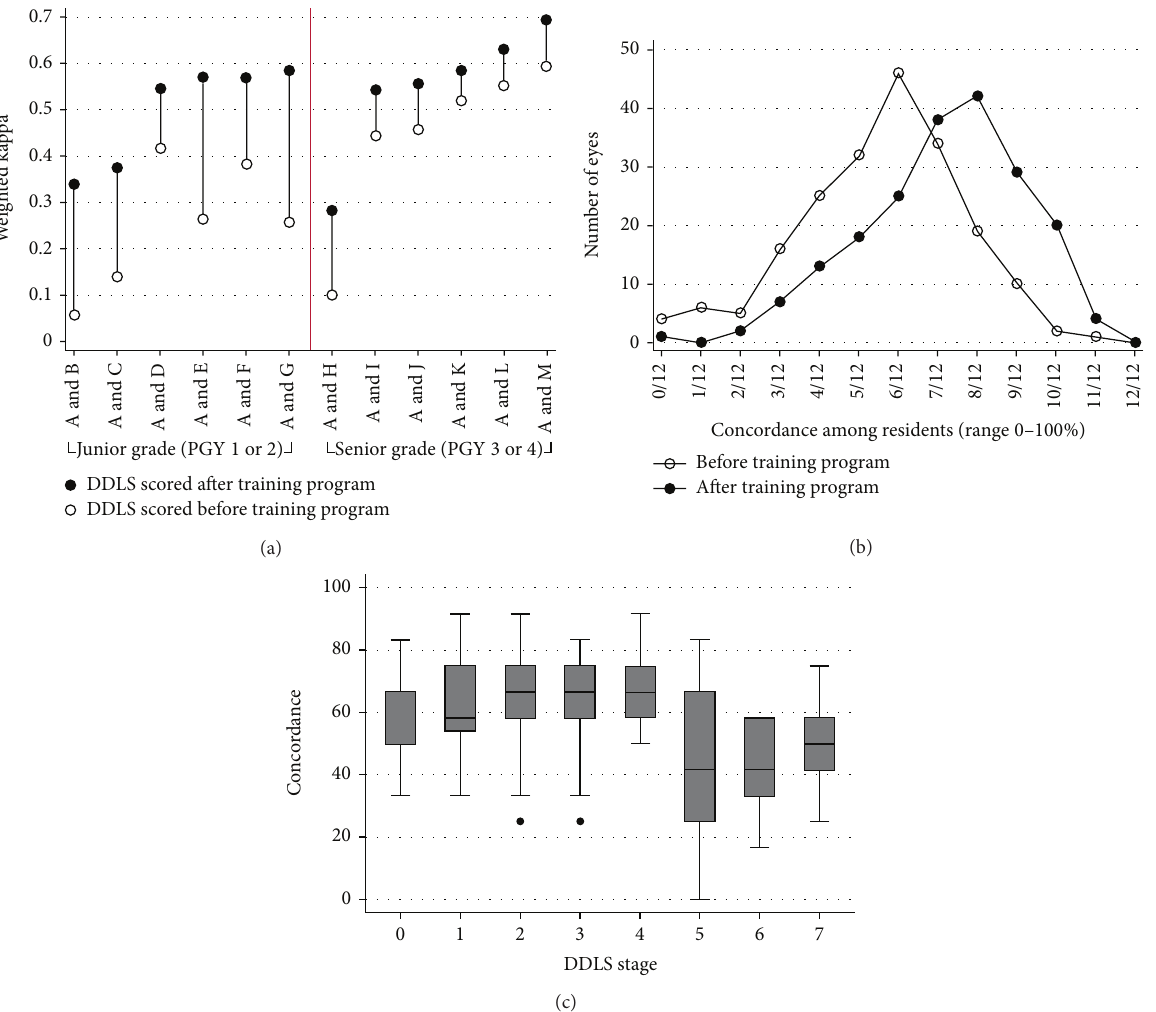
Figure 1: (a) The weighted kappa values for interobserver agreement on the disc damage likelihood scale (DDLS) for the 12 pairs (glaucoma specialist versus all residents). All possible pairs are plotted on the X- axis and the weighted kappa values are shown on the Y- axis. White circles indicate the weighted kappa values before the training program and black circles indicate the weighted kappa values after attending the training program. The residents were divided according to level of training: junior (PGY 1 or 2) and senior (PGY 3 or 4) as indicated by the red line. The weighted kappa values increased after the training program, and this positive effect was greater among junior residents. (b) Concordance among residents on the DDLS evaluation before (white circles) and after (black circles) the training program. Note the right shift (toward better concordance among the residents) after the training program. (c) Concordance among residents according to DDLS stage. Note that the concordance is lowest for stages 5 and 6, whereas it is good for stages